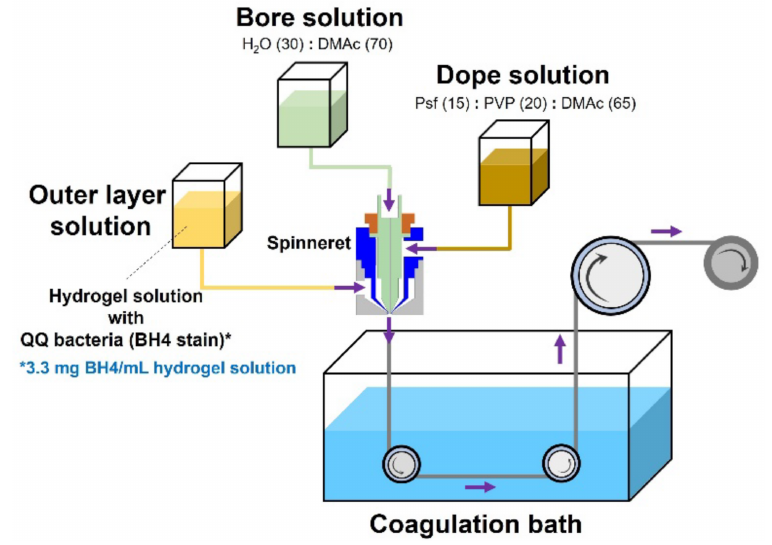
Figure 2. Schematic of fabrication of the double-layered membrane comprising an outer layer containing QQ bacteria (BH4 strain) and an inner polysulfone (Psf) hollow